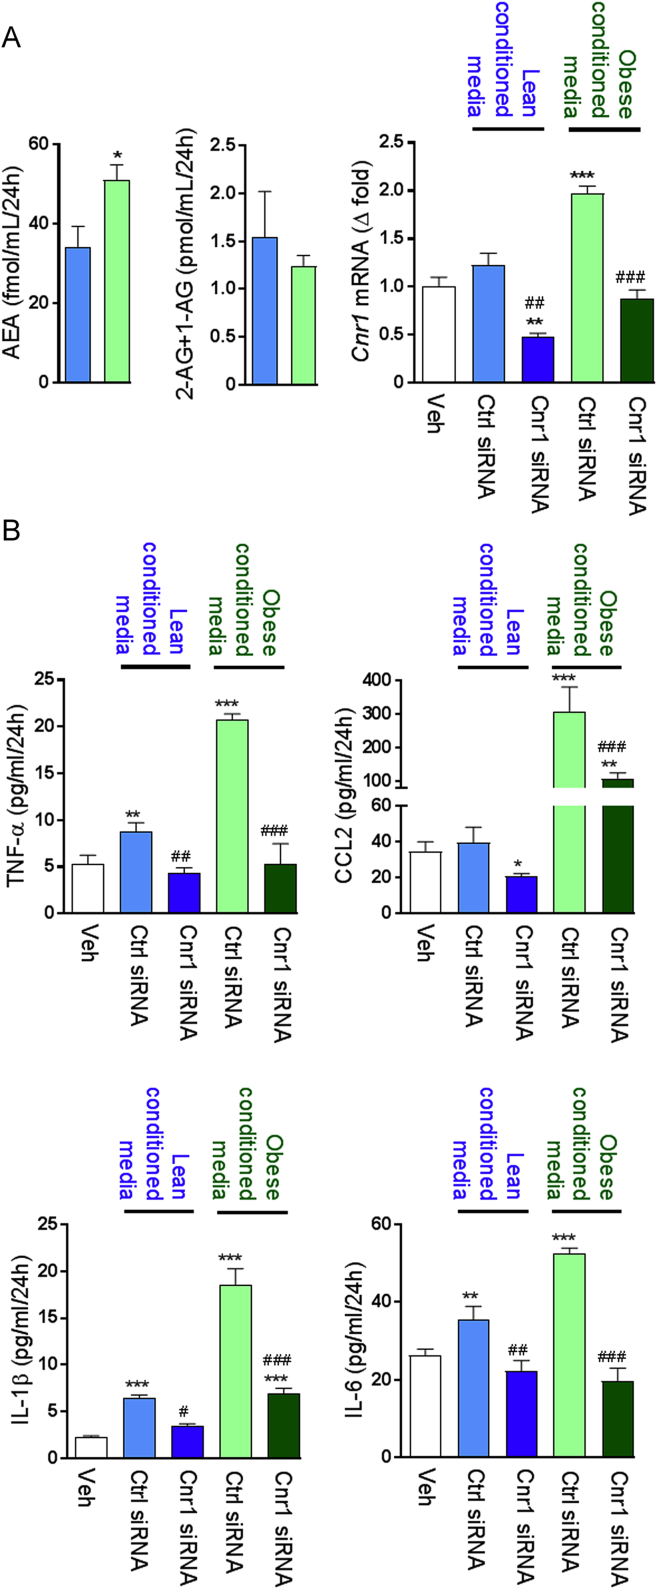
KCs secretary response is influenced by changes in endocannabinoid tone. A Endocannabinoid content in conditioned medium from hepatocytes isolated from lean (blue columns) or obese mice (green columns) and Cnr1 expression in Kupffer cells incubated for 24 h in these conditioned media in presence of either control or Cnr1 siRNA. B Effect of conditioned medium on Kupffer cells secretion of TNF-α, CCL2, IL-1β, and IL-6 after 24 h. Columns and bars represent means ± SEM from 3 individual experiments with n = 4 per condition. Significant differences from values in Veh-treated Kupffer cells (white columns) *P < 0.05, **P < 0.01, ***P < 0.001 or control siRNA treated cells (blue or green columns) #P < 0.05, ##P < 0.01, ###P < 0.001.